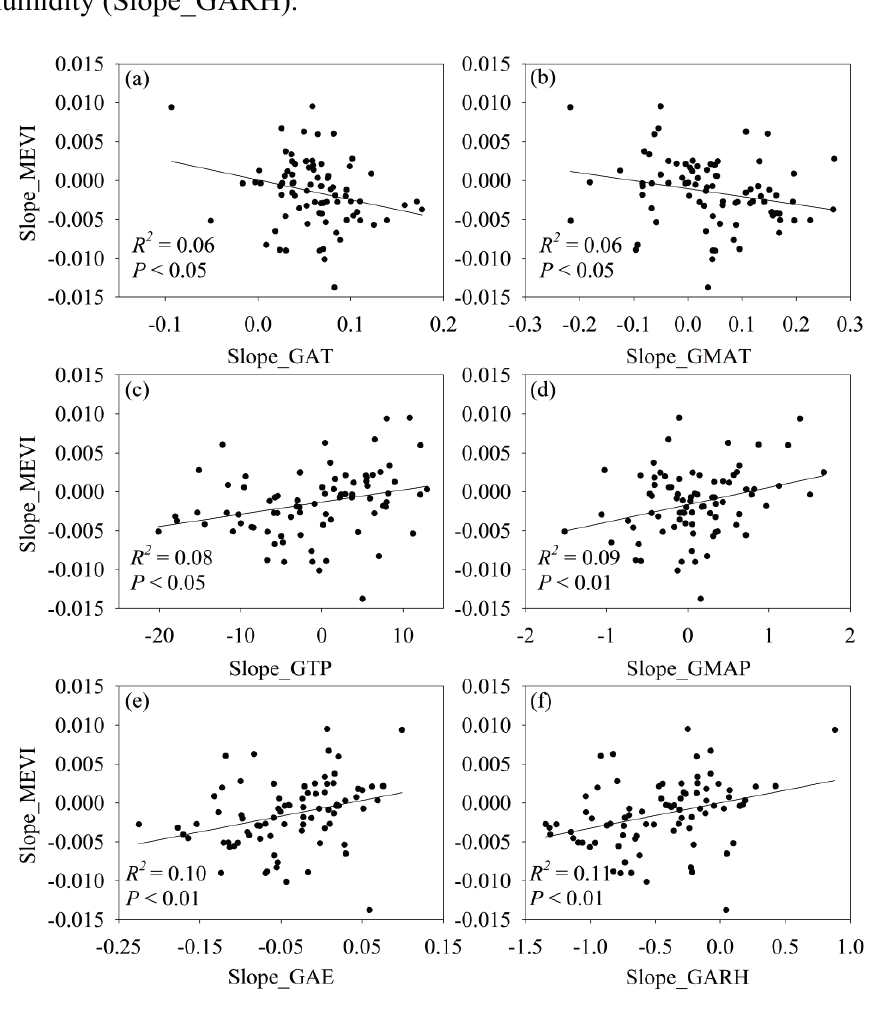
Figure 7. Relationships between several factors: ( a ) the linear trend of the growing season maximum enhanced vegetation index (Slope_MEVI) and the linear trend of the growing season average temperature (Slope_GAT); ( b ) Slope_MEVI and the linear trend of the growing season maximum temperature (Slope_GMAT); ( c ) Slope_MEVI and the linear trend of the growing season total precipitation (Slope_GTP); ( d ) Slope_MEVI and the linear trend of the growing season maximum precipitation (Slope_GMAP); ( e ) Slope_MEVI and the linear trend of the growing season average vapor pressure (Slope_GAE); and ( f ) Slope_MEVI and the linear trend of the growing season average relative humidity